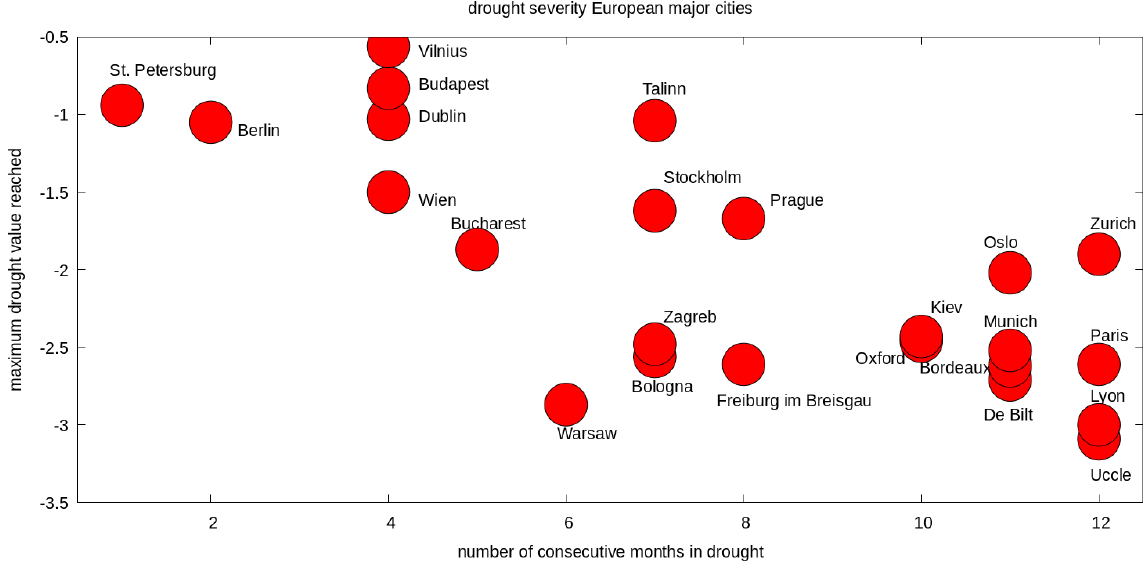
Figure 5. Diagram showing the drought severity of major European cities in 1921. The horizontal axis gives the number of months in 1921 that SPI3 values were below − 0 . 5, and the vertical axis shows the lowest SPI3 value attained in